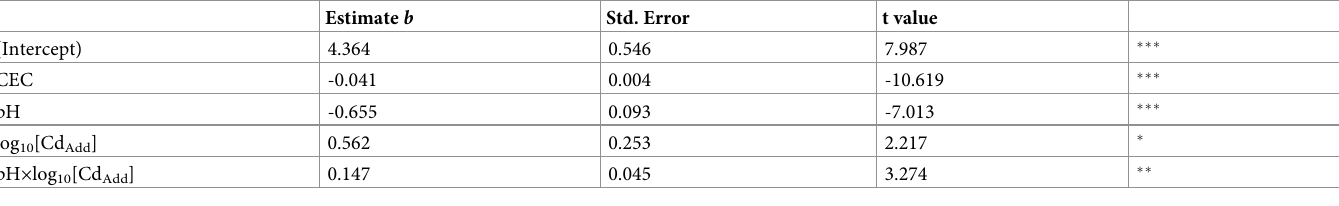
Table 2. Result of multiple regression analysis.